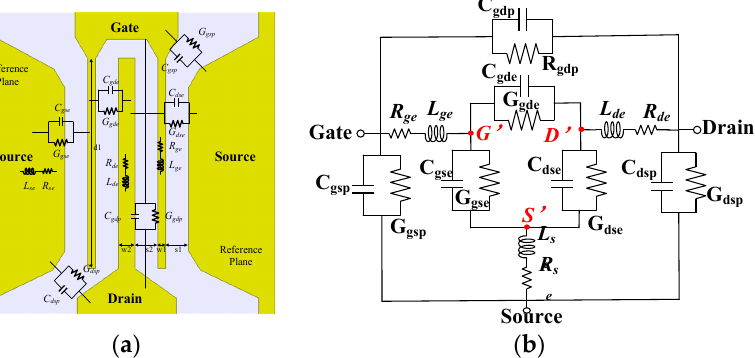
Figure 2. ( a ) The adopted two-finger coplanar GSG PAD layout and ( b ) the equivalent circuit of GSG PAD layout.